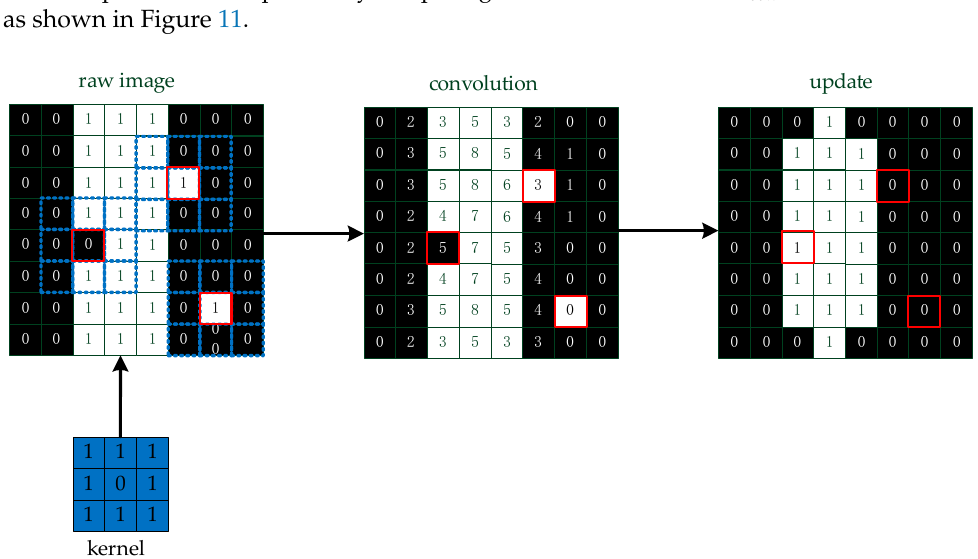
Table 3. Image skeleton extraction. The contour of the image is extracted by the skeleton extraction algorithm and lines are refined into single pixels. Similarly, the skeleton made up of two-dimensional points is reduced by the image skeleton. Data